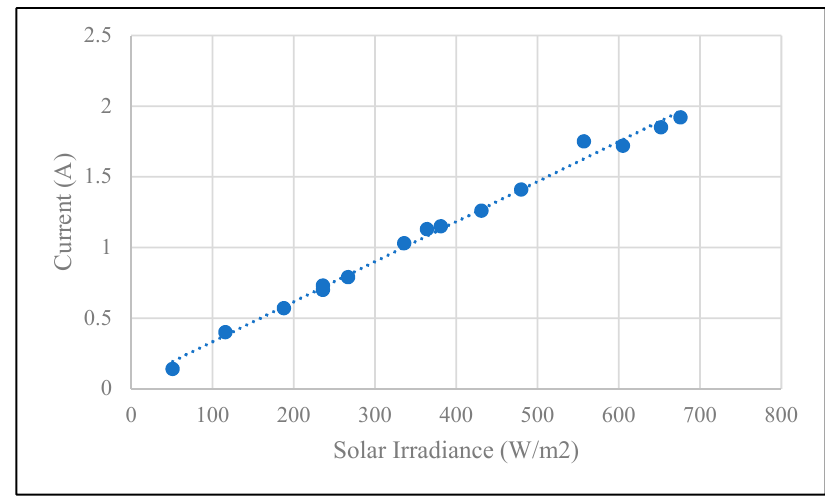
Figure 9. Direct relationship between current produced by the PV panel and the solar irradiance.